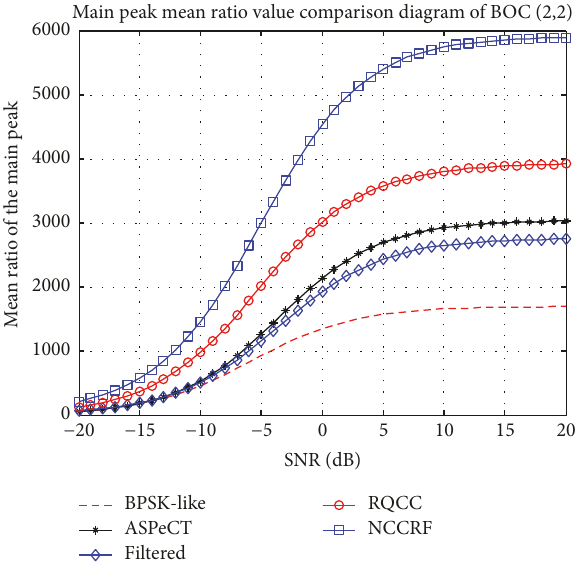
Figure 7: The MPMR comparison of BOC ( 6,1 ). Main to side peak ratio value comparison diagram of BOC (2,2)